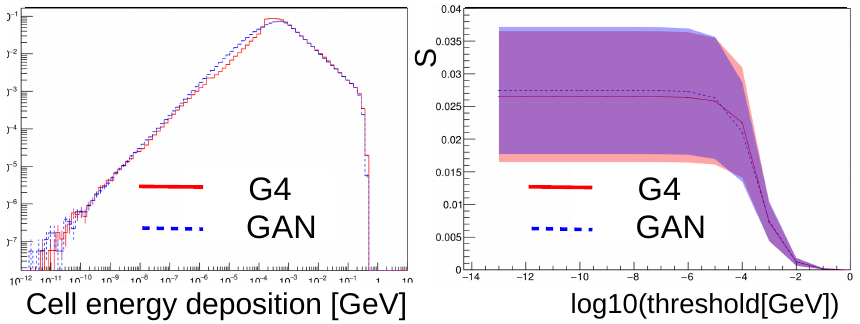
Figure 3. GAN vs, Geant4 for 2-500 GeV. Left: individual cell energies. Right: fraction of cells above a threshold for di ff erent values of